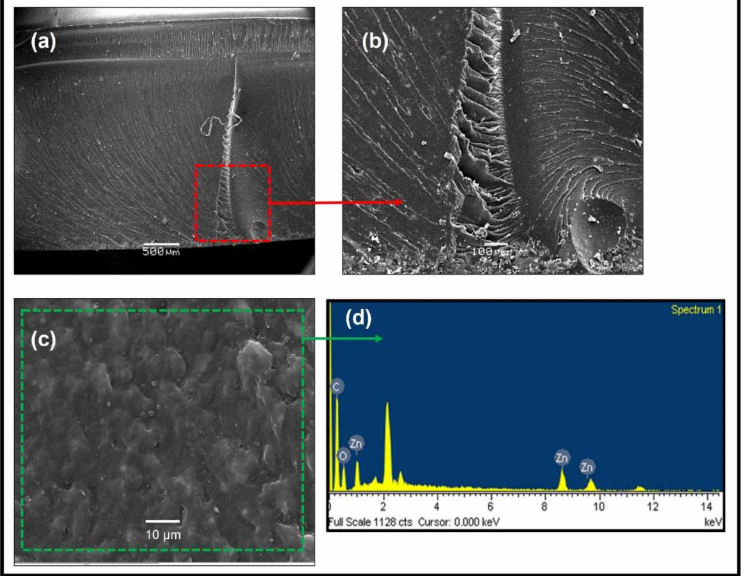
Figure 12. ( a , b ) SEM analysis of the fracture of hybrid materials (HMF2), ( c , d ) SEM microscopy of the analyzed surface and EDS